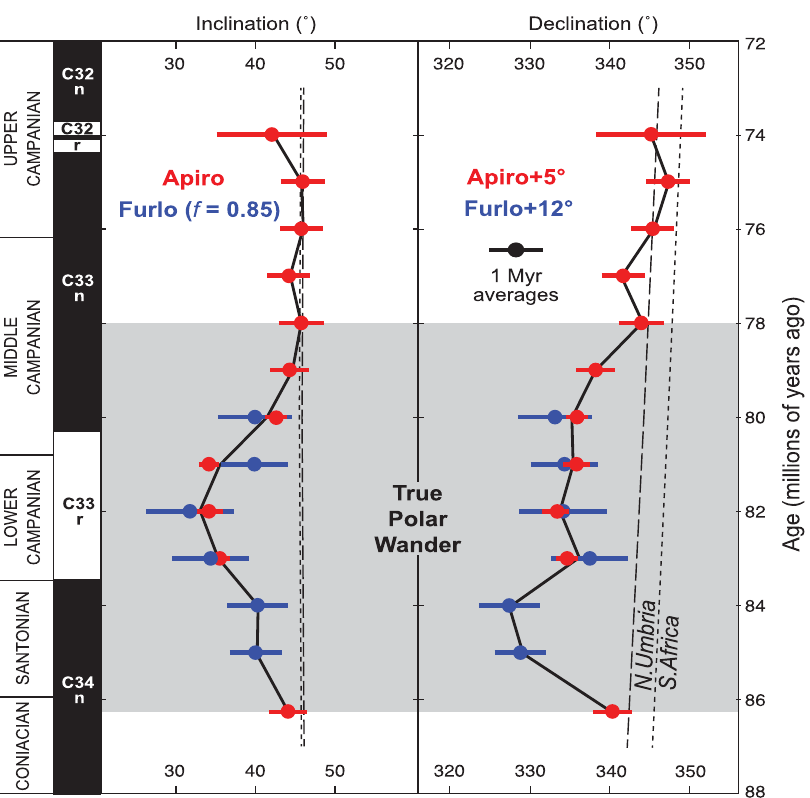
Fig. 2 Palaeomagnetic inclination and declination of Italy in Late Cretaceous time. One-million-year averages and error bars of the 1090 samples were calculated using Fisher statistics (excluding outliers interpreted as geomagnetic excursions, spurious magnetizations, or slumps; reversed polarity data were reversed for mean calculations). The temporary ~10 – 15° excursion of both inclination and declination is interpreted as a true polar wander oscillation. Directional predictions for a representative site (43.5°N, 12.9°E) from the global apparent polar wander path of Torsvik et al. 72 and the tectonic model of van Hinsbergen et al. 71 are shown in both North Umbrian and South African coordinates. Apiro declination data have been adjusted for local rotation to match those reference frames ( + 5°), and Furlo data have been corrected to match optimally the Apiro dataset with local rotation ( + 12°) and inclination shallowing 75 ( f = 0.85). Global polarity time scale 76 shown on left. Age models provided in the Methods. Supplementary Fig. 7 and Supplementary Data 1 for raw data before